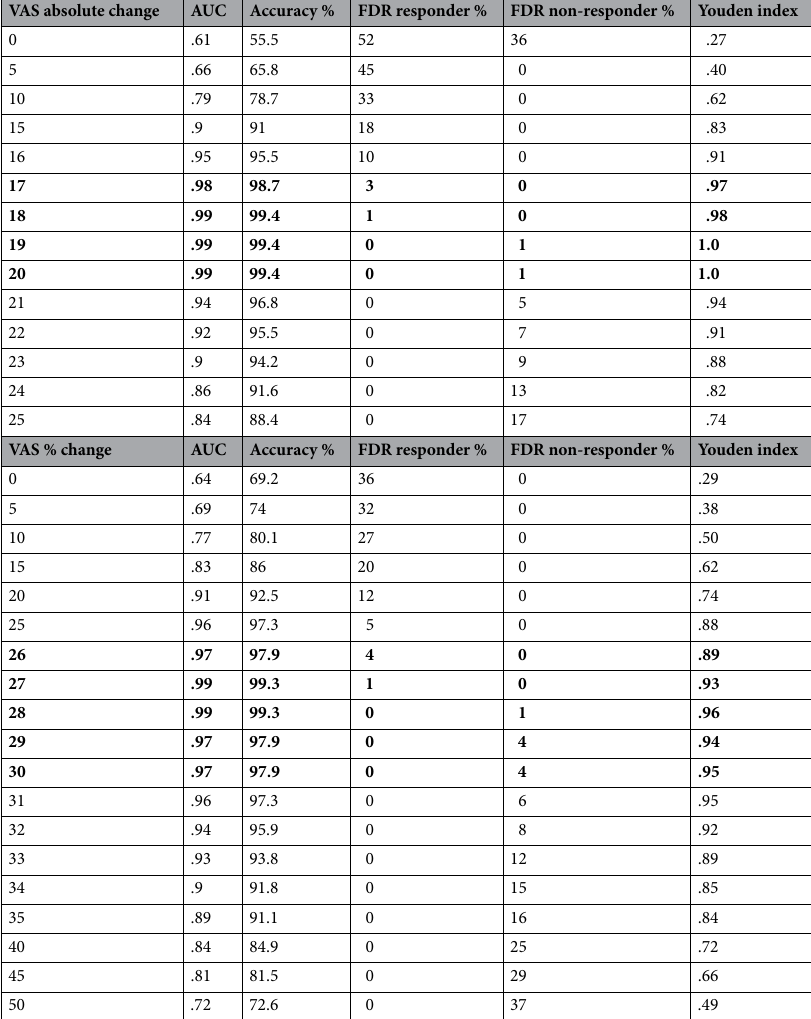
Table 1. Cutoff values from logistic regression machine learning. The VAS absolute change is the absolute change in VAS pain intensity ratings from the pretests to the posttest. The VAS percent change is the percentage change in VAS pain intensity ratings from the pretests to the posttest. Bold type indicates q ≤ 5%. VAS visual analog scale, AUC area under the curve, FDR false-discovery